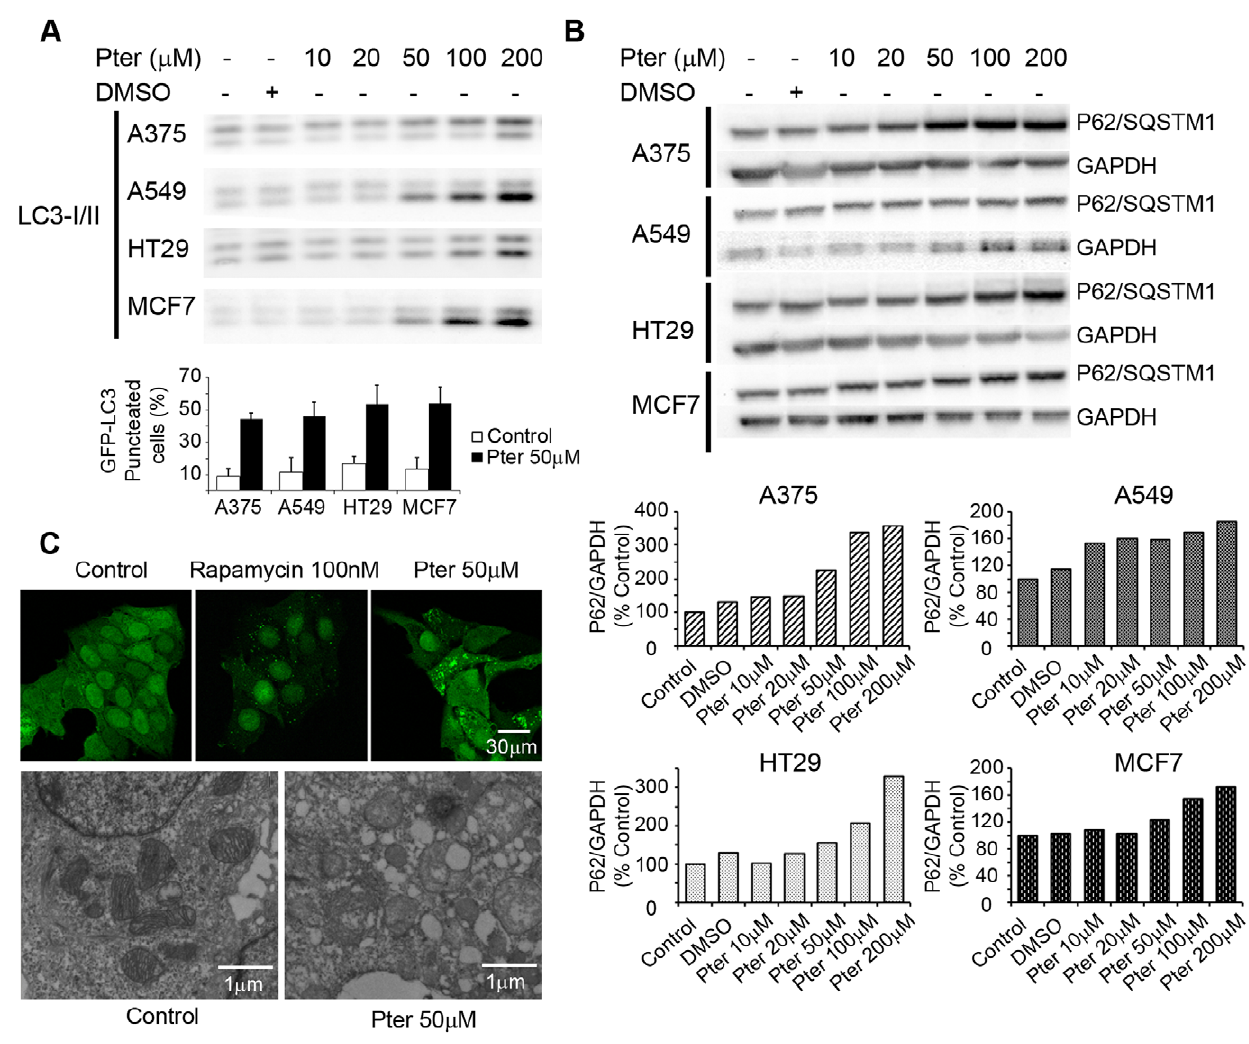
Figure 4. Effects of pterostilbene on autophagic flux. Proteins were detected by western blot with LC3A/B (A) or SQSTM1/p62 antibodies (B). Graphic shows the percentage of induction of eGFP-LC3 punctuation/aggregation in control and Pter (50 m M) conditions after 24 h of treatment (A). Densitometric analysis of SQSTM1/p62 correlated with GAPDH levels. The ratio in untreated control cells was set to 100% (B). MCF7-eGFP-LC3 cells were visualized by confocal and transmission electronic microscopy after treatment with 50 m M Pter for 24 h or 100 nM Rapamycin for 1 h (C).